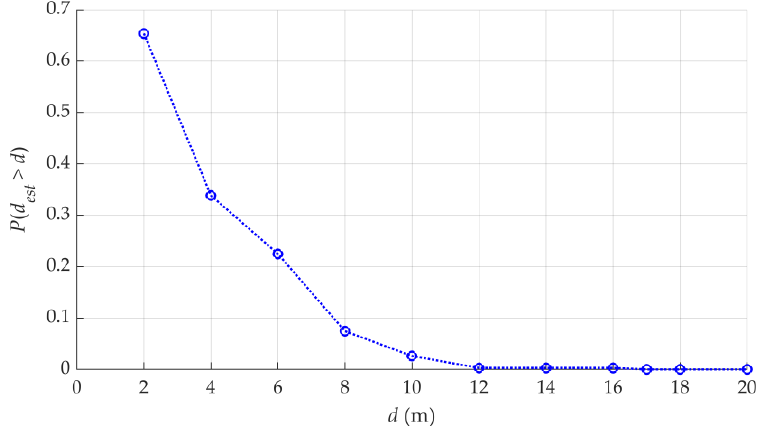
Figure 23. Probability of choosing a locator node that is located at least d meters from the wristband in the case of M = 5.